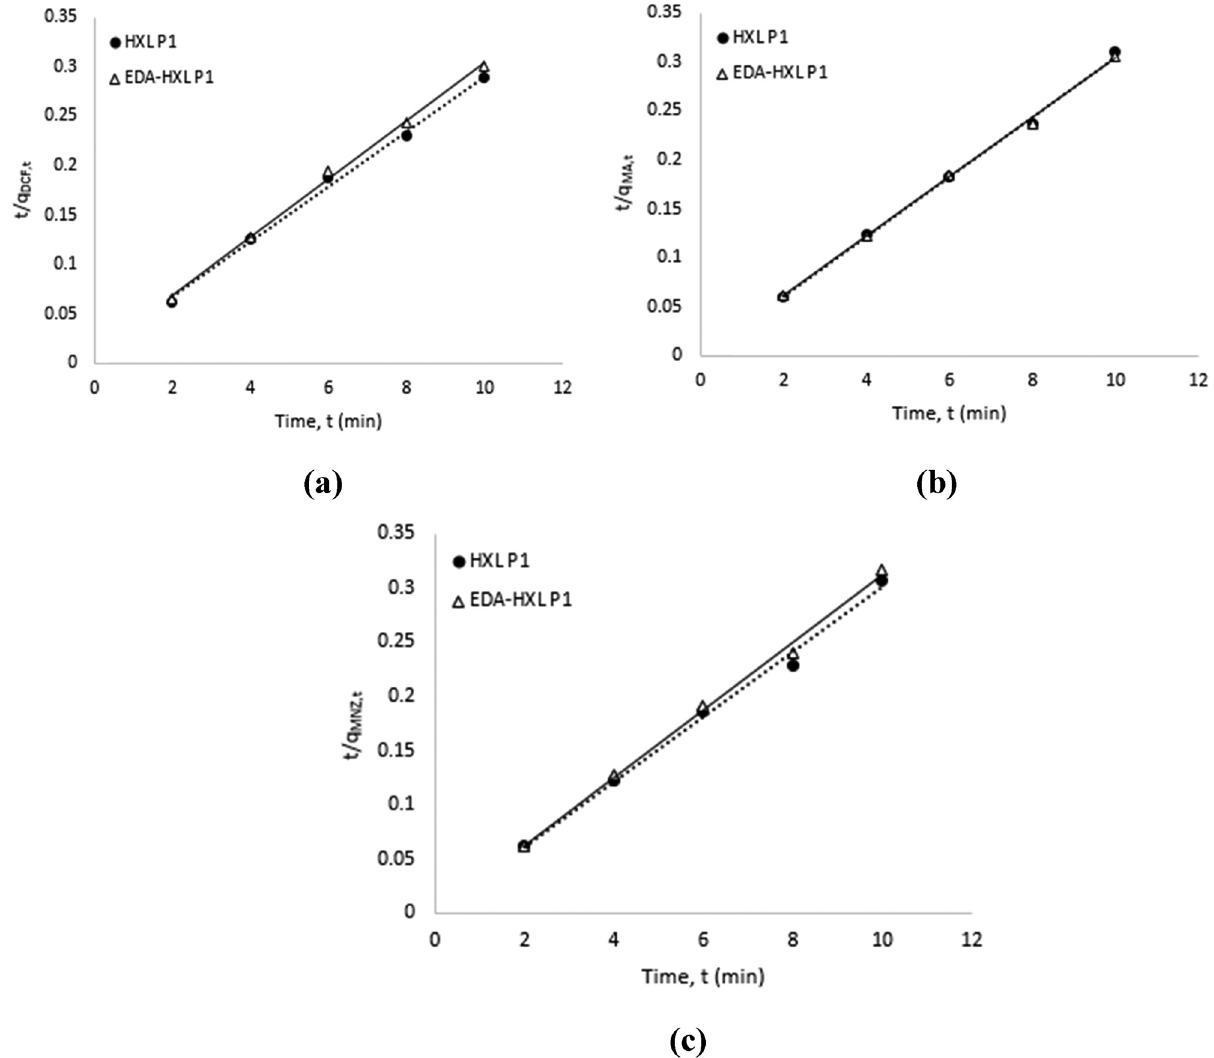
Figure A4: Pseudo - second - order kinetic model for the adsorption of ( a ) DCF, ( b ) MA, and ( c ) MNZ by HXL PI and EDA - HXL P1